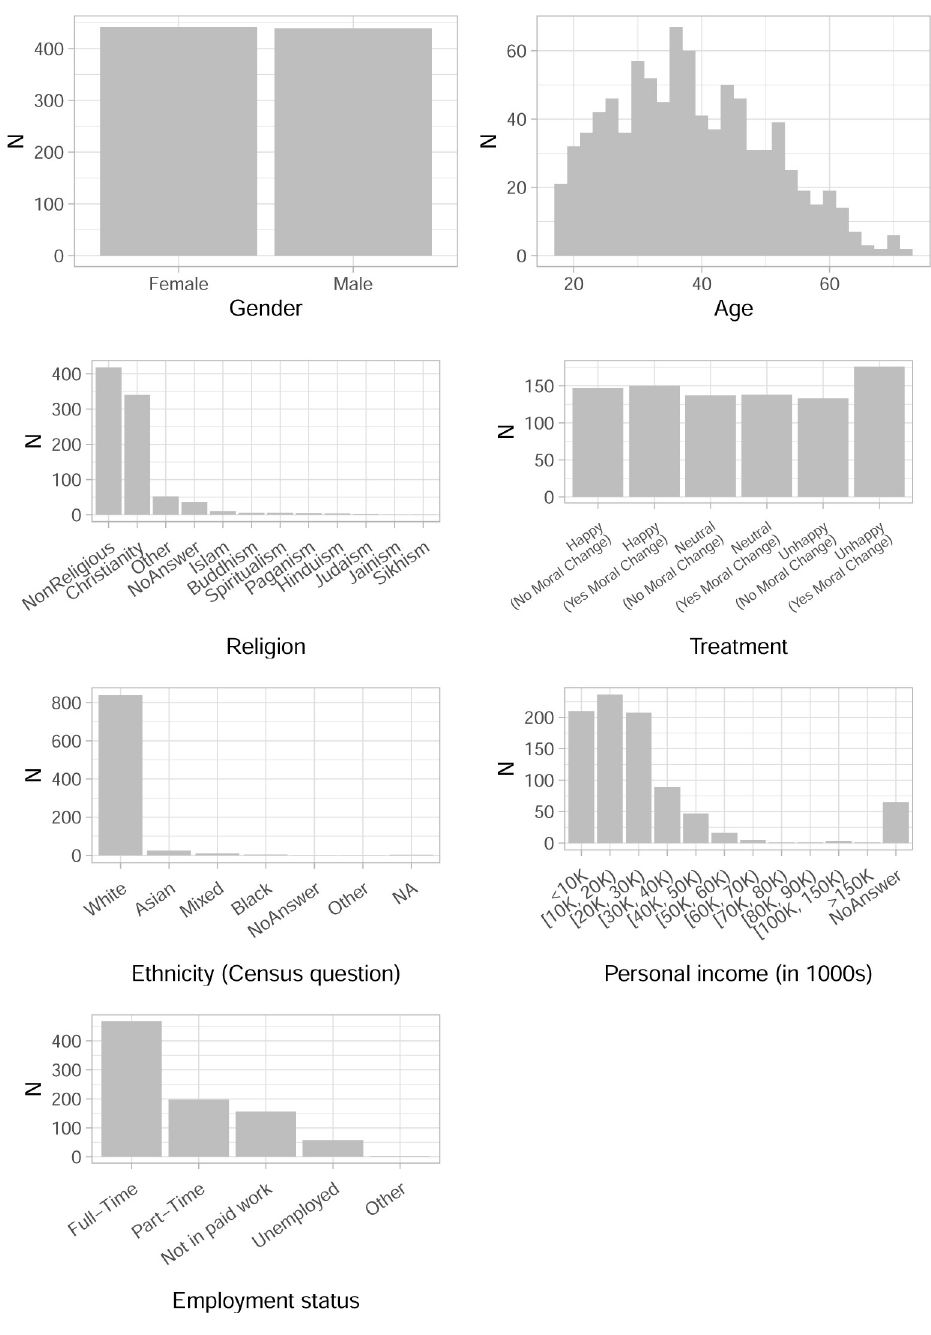
Fig 2. Covariate distributions in the